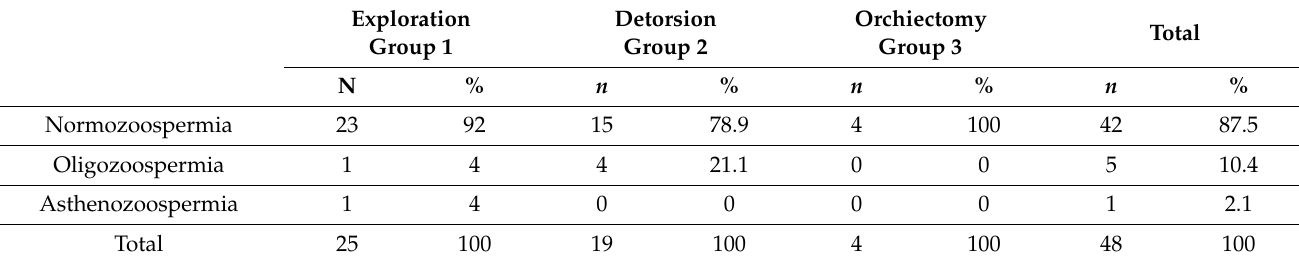
Table 3. Semen analysis according to spermiogram categories.